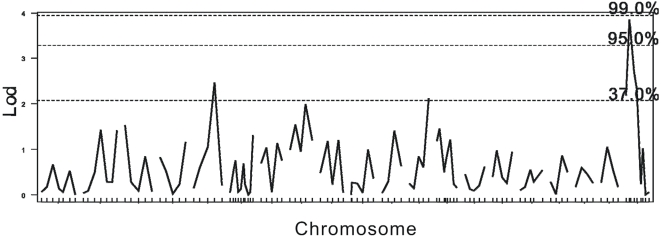
Linkage data for age at VO in the reciprocal cross of F2 population (C3HB6F2).The horizontal axes indicate chromosomal locations and marker order between markers. Dashed lines indicate genome-wide suggestive (P<0.63), empirical significant (P<0.05), and (P<0.01), LOD statistics at 2.03, 3.27, and 3.93, respectively.